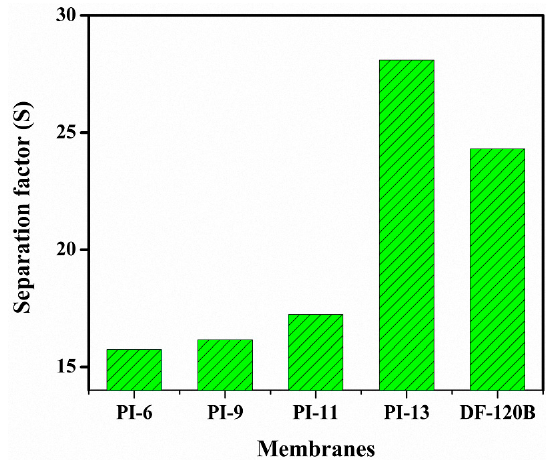
Figure 8. Separation factor (S) for HCl/FeCl 2 mixtures at 25 °C using BPPO-based AEMs with increasing amounts of PI.